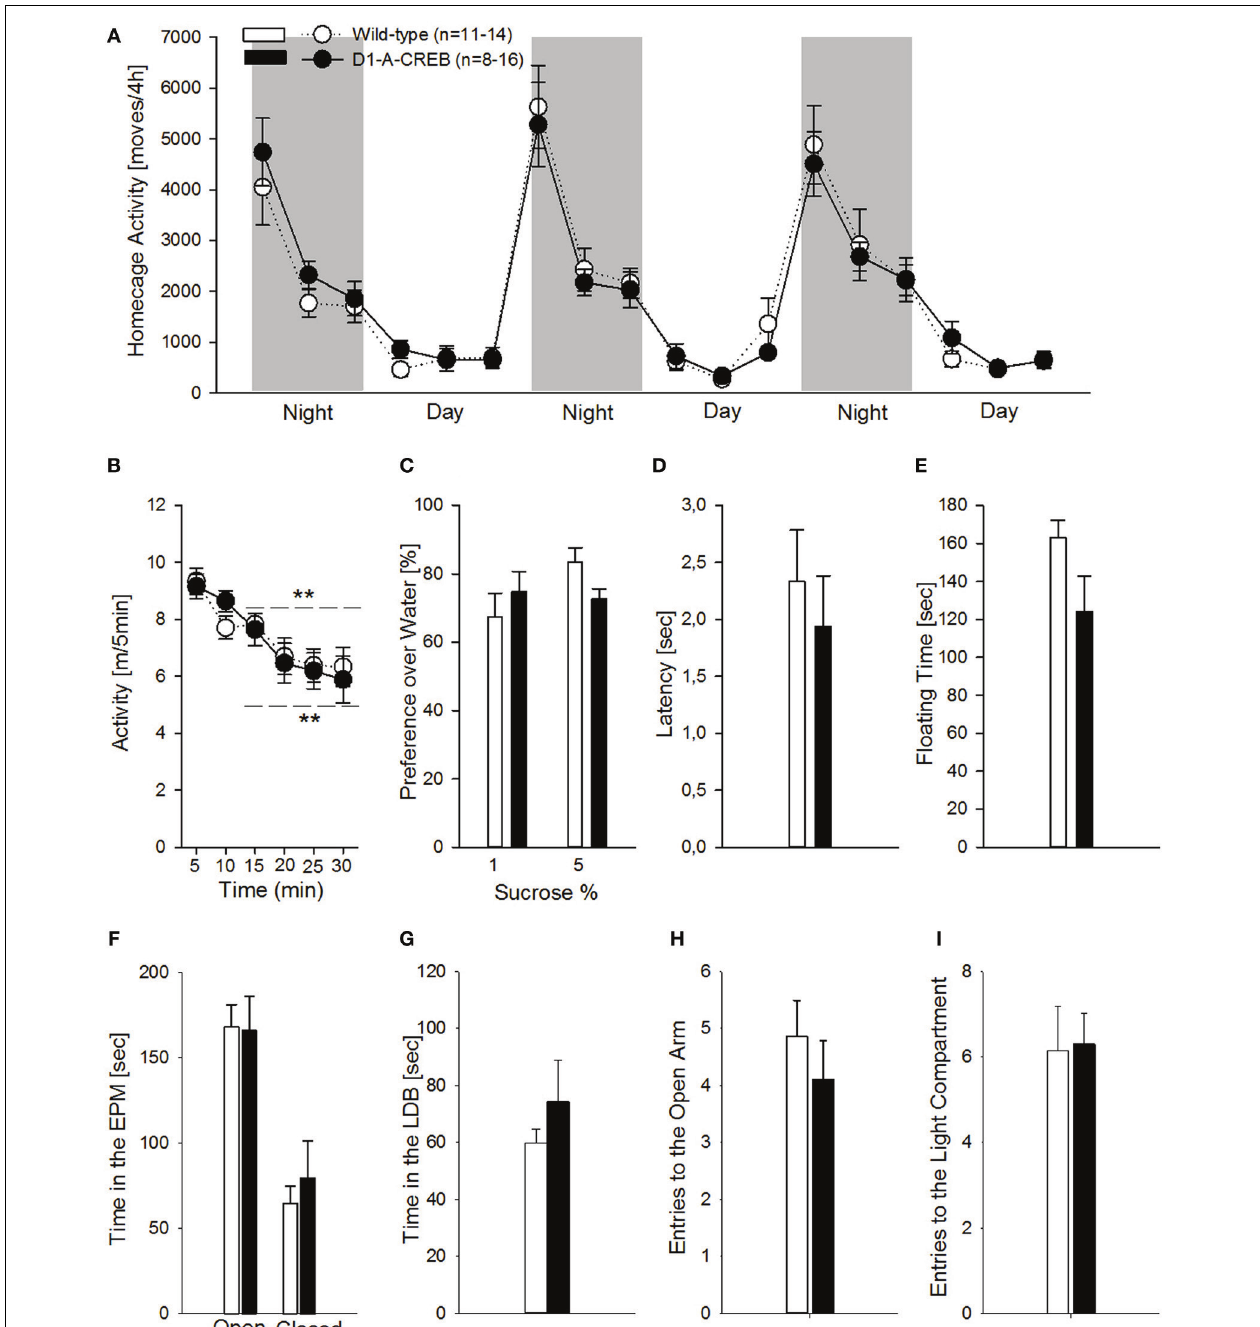
FIGURE 4 | Locomotor, anxiety- and depressive-like responses in D1R-A-CREB mice. (A) Spontaneous home cage locomotor activity measured by the e-motion system is indistinguishable between wild-type ( n = 11) and D1-A-CREB mice ( n = 8) genotype effect [ F (1 , 102) = 0, p = 1]. Two-Way ANOVA indicates a phase effect [ F (1 , 102) = 141 . 8, P < 0 . 0001] and all day points are significantly different from all night points Phase × time point interaction effect [ F (2 , 102) = 18 . 5, P < 0 . 0001]. (B) Habituation to novelty in activity chambers in wild-type ( n = 14) and D1-A-CREB ( n = 13) mice. During the first 30min exposure both genotypes displayed a progressive decrease in locomotor activation indicating habituation to novelty.